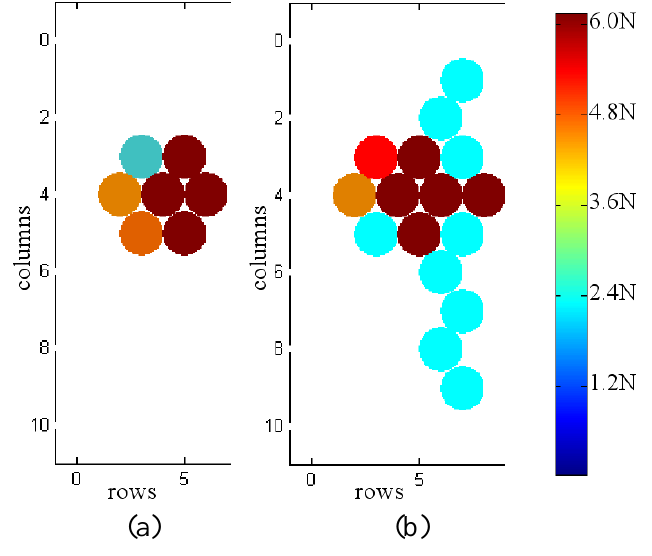
Figure 8. Tactile image of a circular object without ( a ) and with ( b ) insulating the